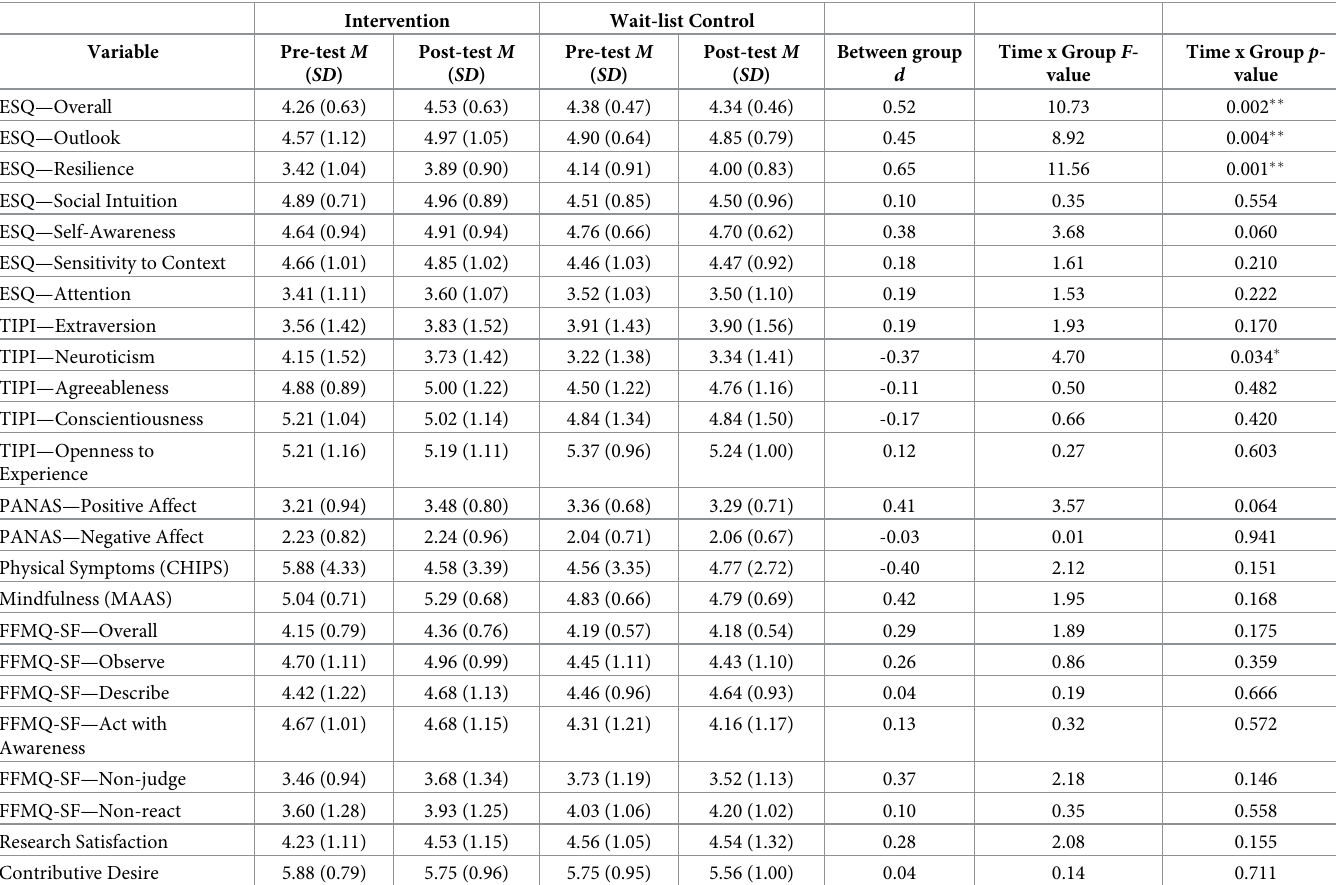
Table 1. Phase 1 pre- and post-test Means ( M ), Standard Deviations ( SD ), between group effect sizes ( d ), and RMANOVA results ( F -value, p -value) for intervention and control